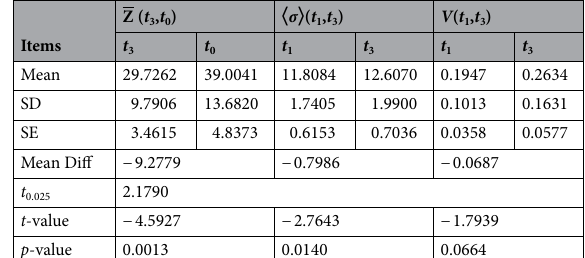
Table 3. Result of paired samples t -test for Z ( t 3 – t 0 ),